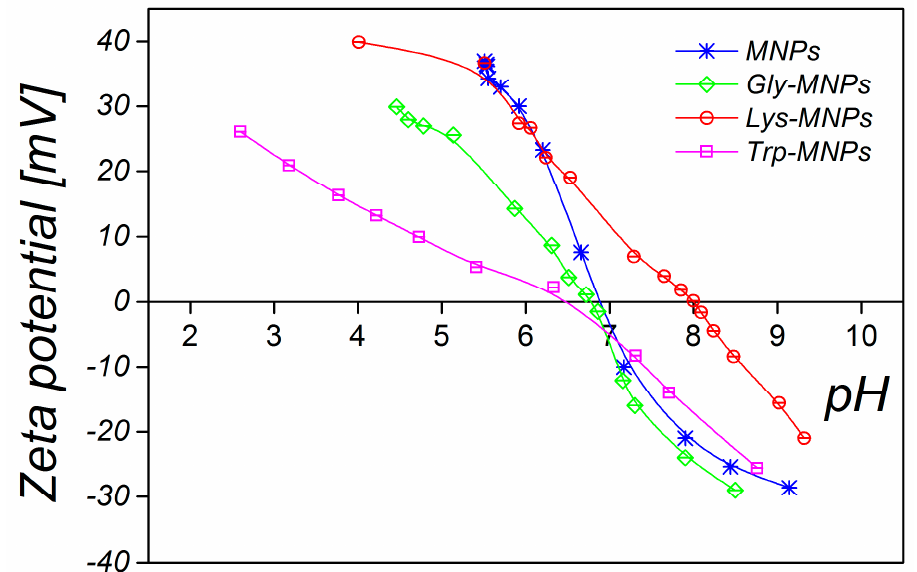
Figure 7. pH-dependent zeta potential of MNPs and AA–MNPs.